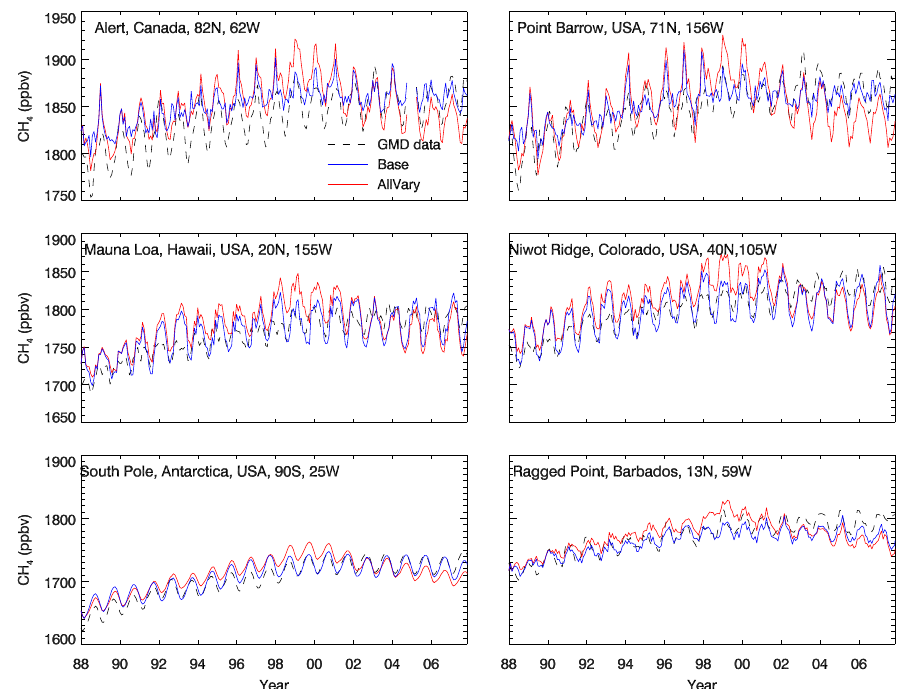
Figure 5. Monthly methane (ppbv) from the Base and AllVary scenarios and observations from six GMD stations. Similar plots for the other scenarios are given in Figs. S8 to S11.